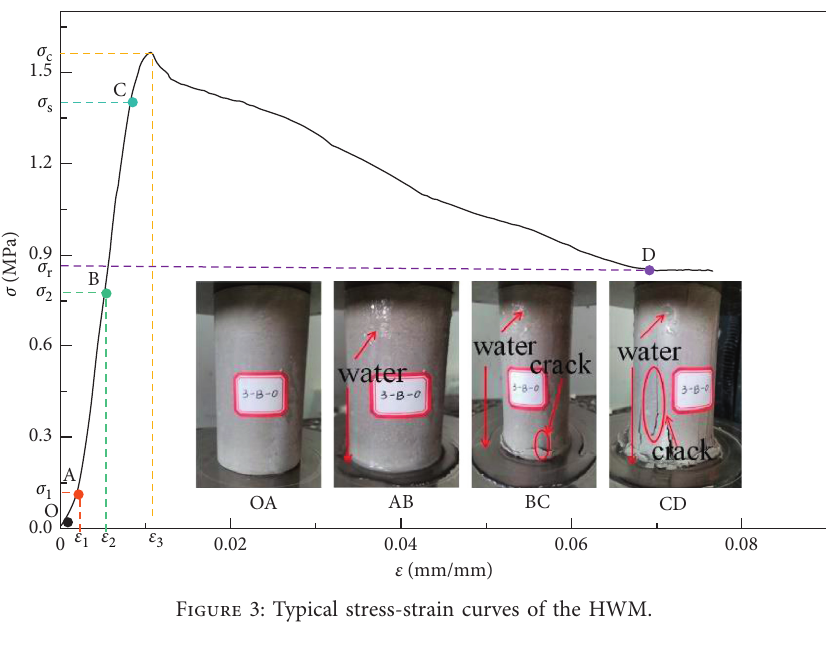
Figure 3: Typical stress-strain curves of the